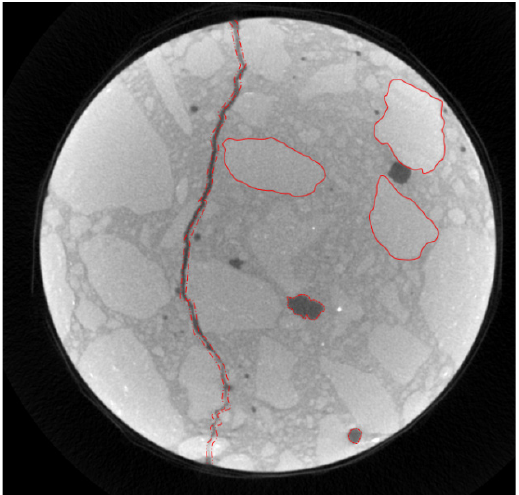
Figure 3. Schematic diagram of cracks, voids, and sandstone.